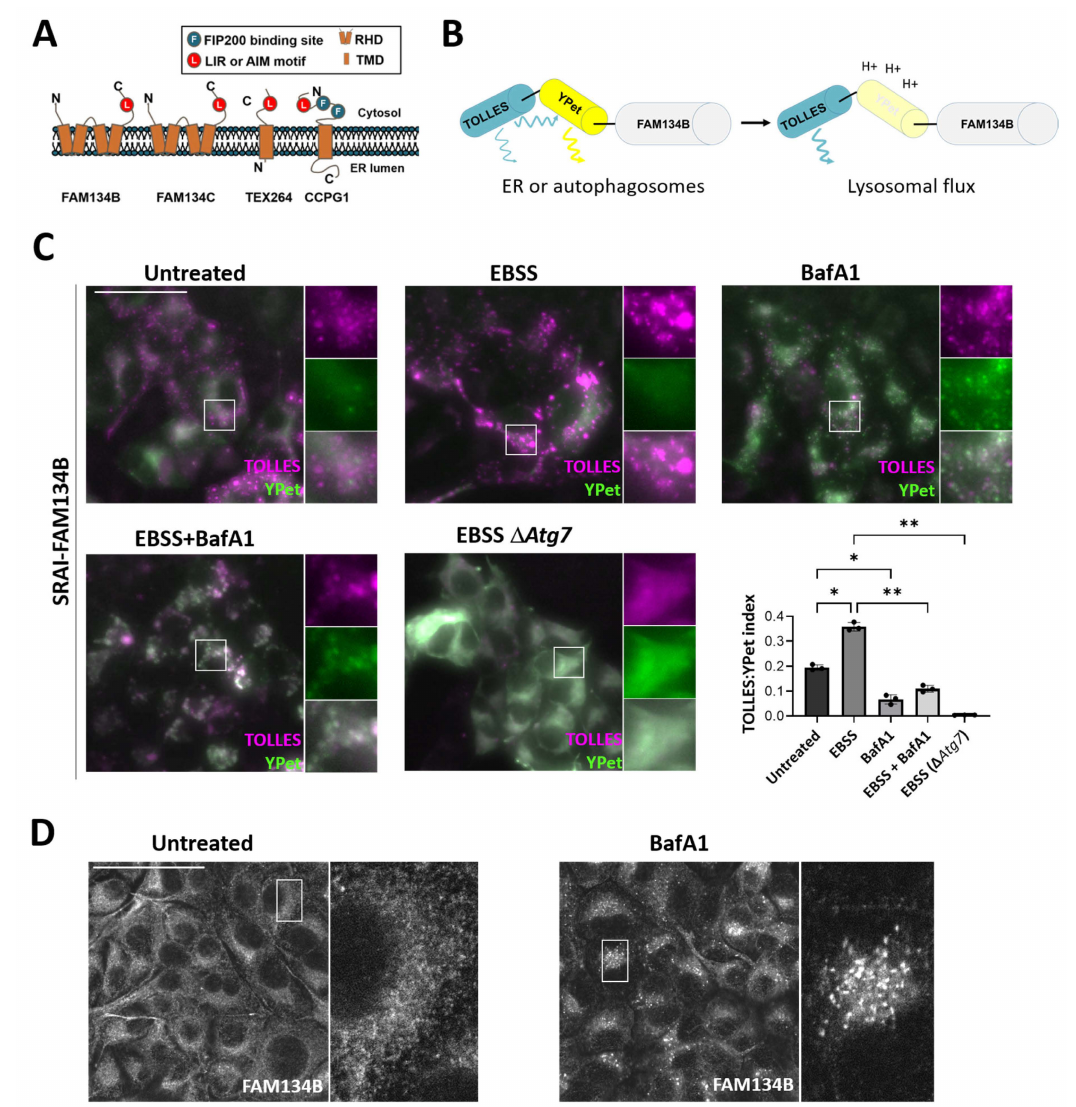
Figure 4. FAM134B flux can be monitored using the SRAI probe. ( A ) Schematic representing some of the characterized ER-phagy cargo receptors. LIR, LC3 interacting region; AIM, ATG8 interaction region; RHD, reticulon homology domain; TMD, transmembrane domain. ( B ) Schematic of the expected fluorescence profile of SRAI (TOLLES-YPet)-FAM134B within different compartments (representing TOLLES as a FRET donor and YPet as a FRET acceptor). TOLLES is represented in blue and YPet in yellow or faint yellow if quenched. ( C ) Imaging-based autophagic flux assay in PDAC cells stably expressing SRAI-FAM134B (transfected with sgControl or sg Atg7 ) in full nutrients (untreated) or following 4 h starvation in the presence or absence of BafA1 (50 nM) and imaged using automated widefield microscopy. Representative immunofluorescence images of TOLLES (magenta) and YPet (green). Bar = 50 µ m. On the bottom right, quantification of the TOLLES:YPet index ( n = 3, 6 fields per replicate were analyzed with 60–100 cells per field, ± S.D., * = p < 0.05, ** = p < 0.01, 1-way ANOVA followed by Holm-Š í d á k comparisons). ( D ) Immunofluorescence images of PDAC